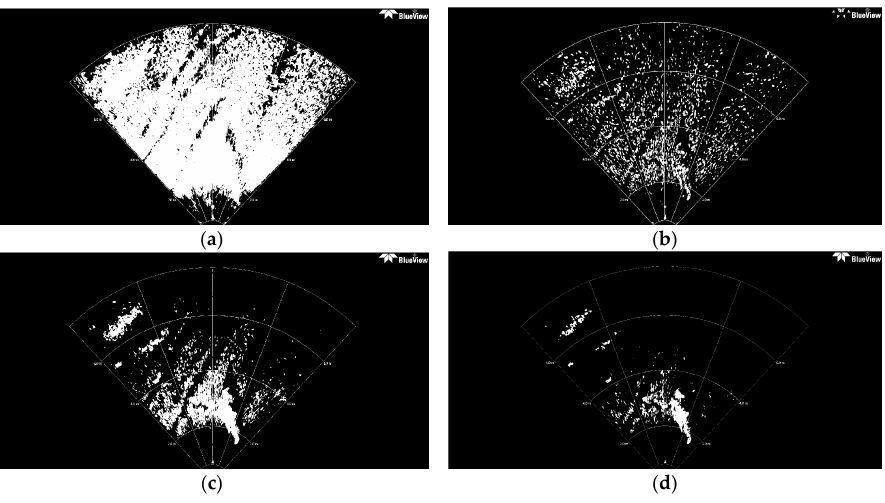
Figure 9. ( a ) Traditional Otsu TSM, Th = 0.1176; ( b ) Local TSM, Th = 0.0941; ( c ) Iterative TSM, Th = 0.2990; ( d ) Maximum entropy TSM, Th = 0.4118.